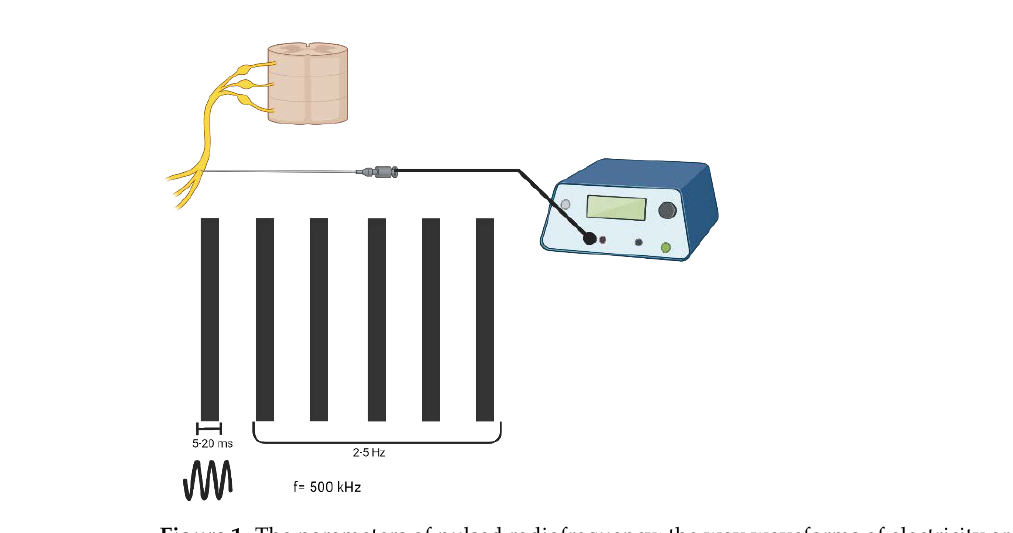
Figure 1. The parameters of pulsed radiofrequency; the way waveforms of electricity are delivered to tissues. Created with BioRender.com, accessed on 6 September 2022.